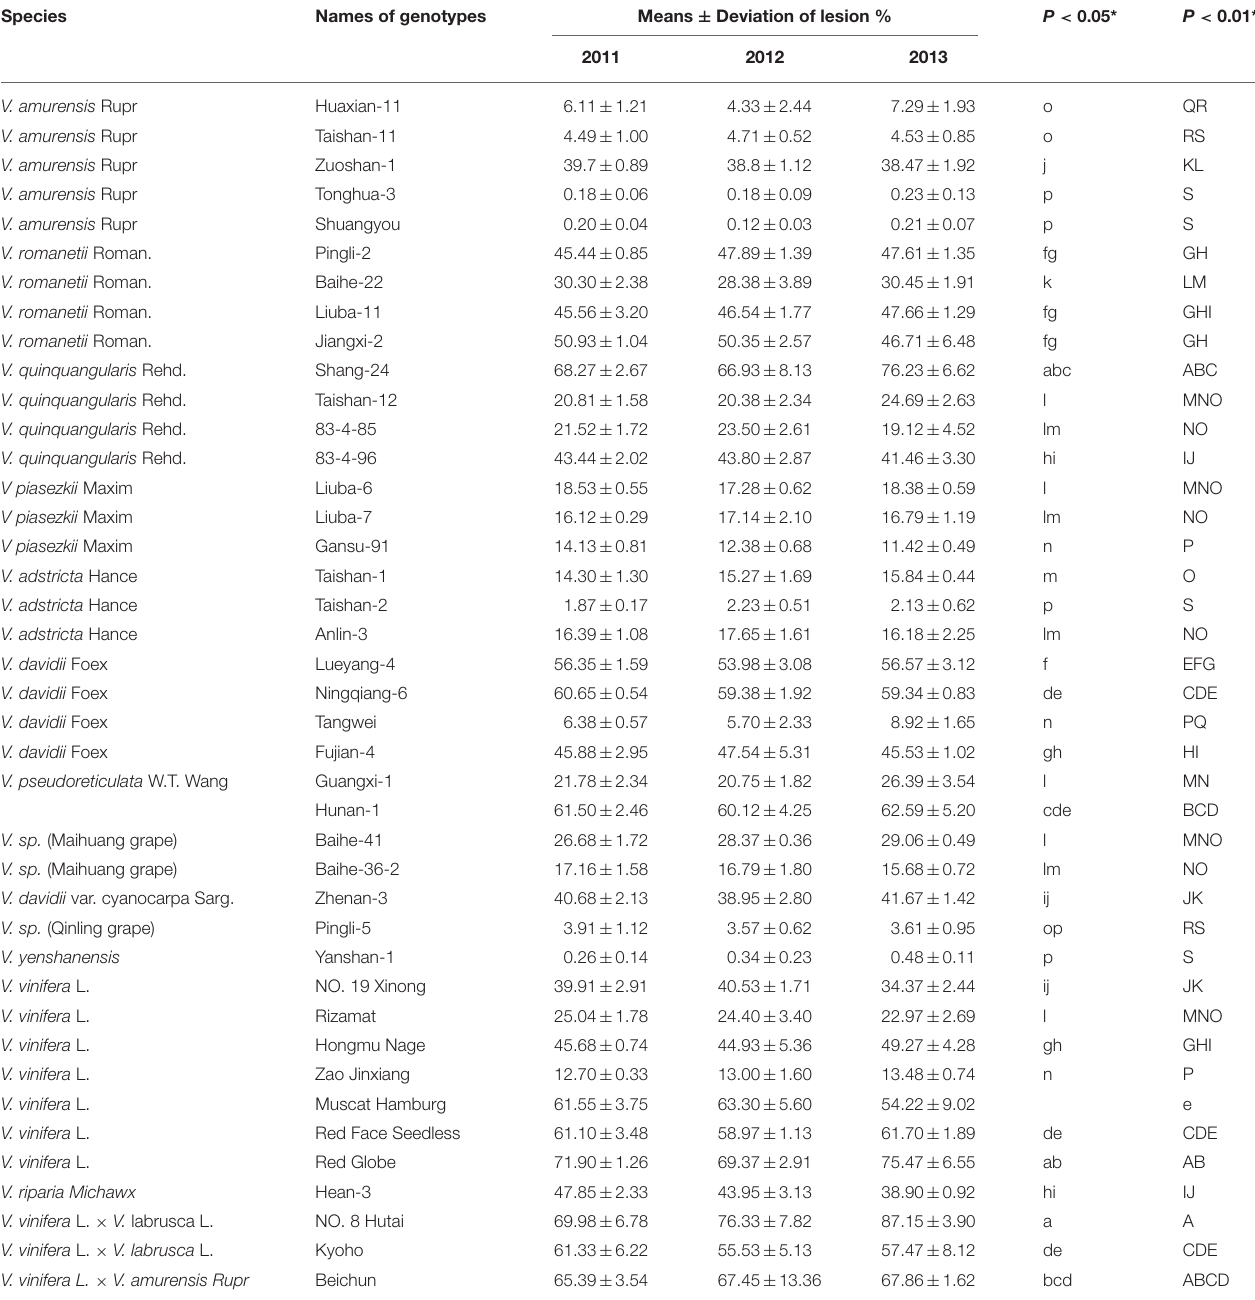
TABLE 2 | Means ± standard deviations of 3 years of lesions percent ages on the leaves of 41 Vitis genotypes infected with B. cinerea over 3 years, along with significance analysis of disease severities.